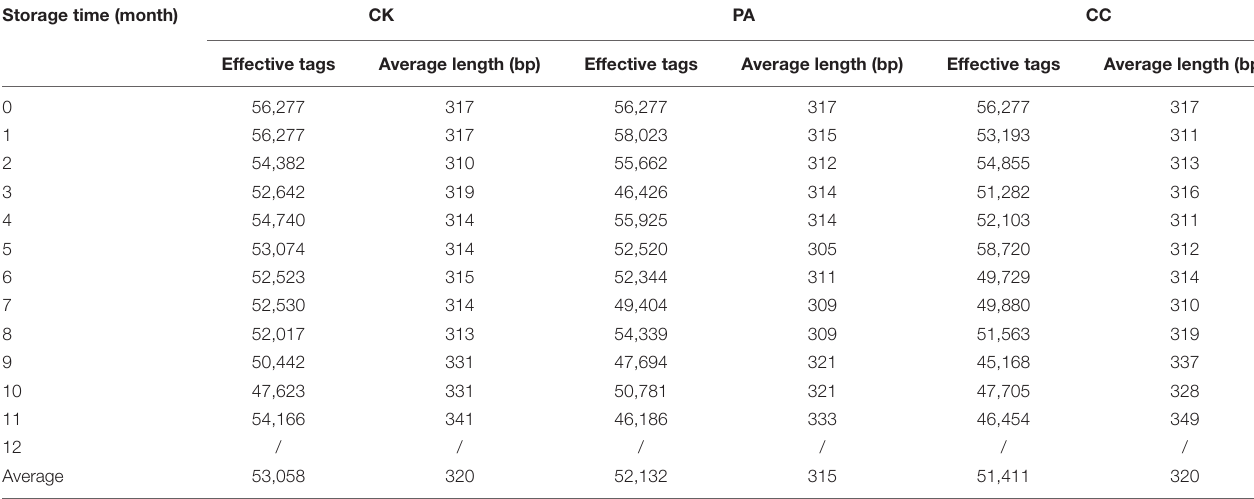
TABLE 3 | Summary of pyrosequencing analysis in stored maize treated with complex essential oils (CC), PA, and untreated (CK). Storage time (month)